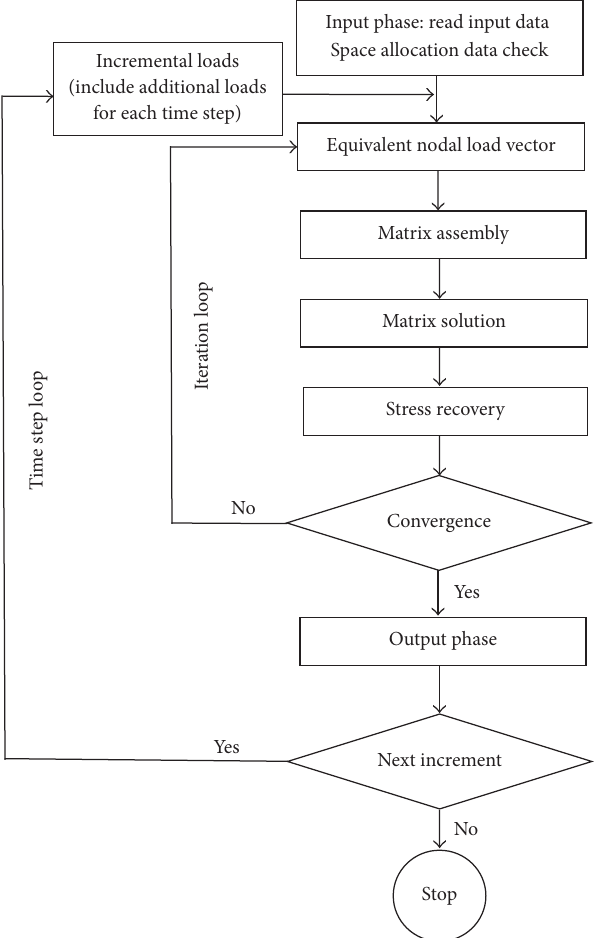
Figure 3: Flow diagram of nonlinear solution with additional